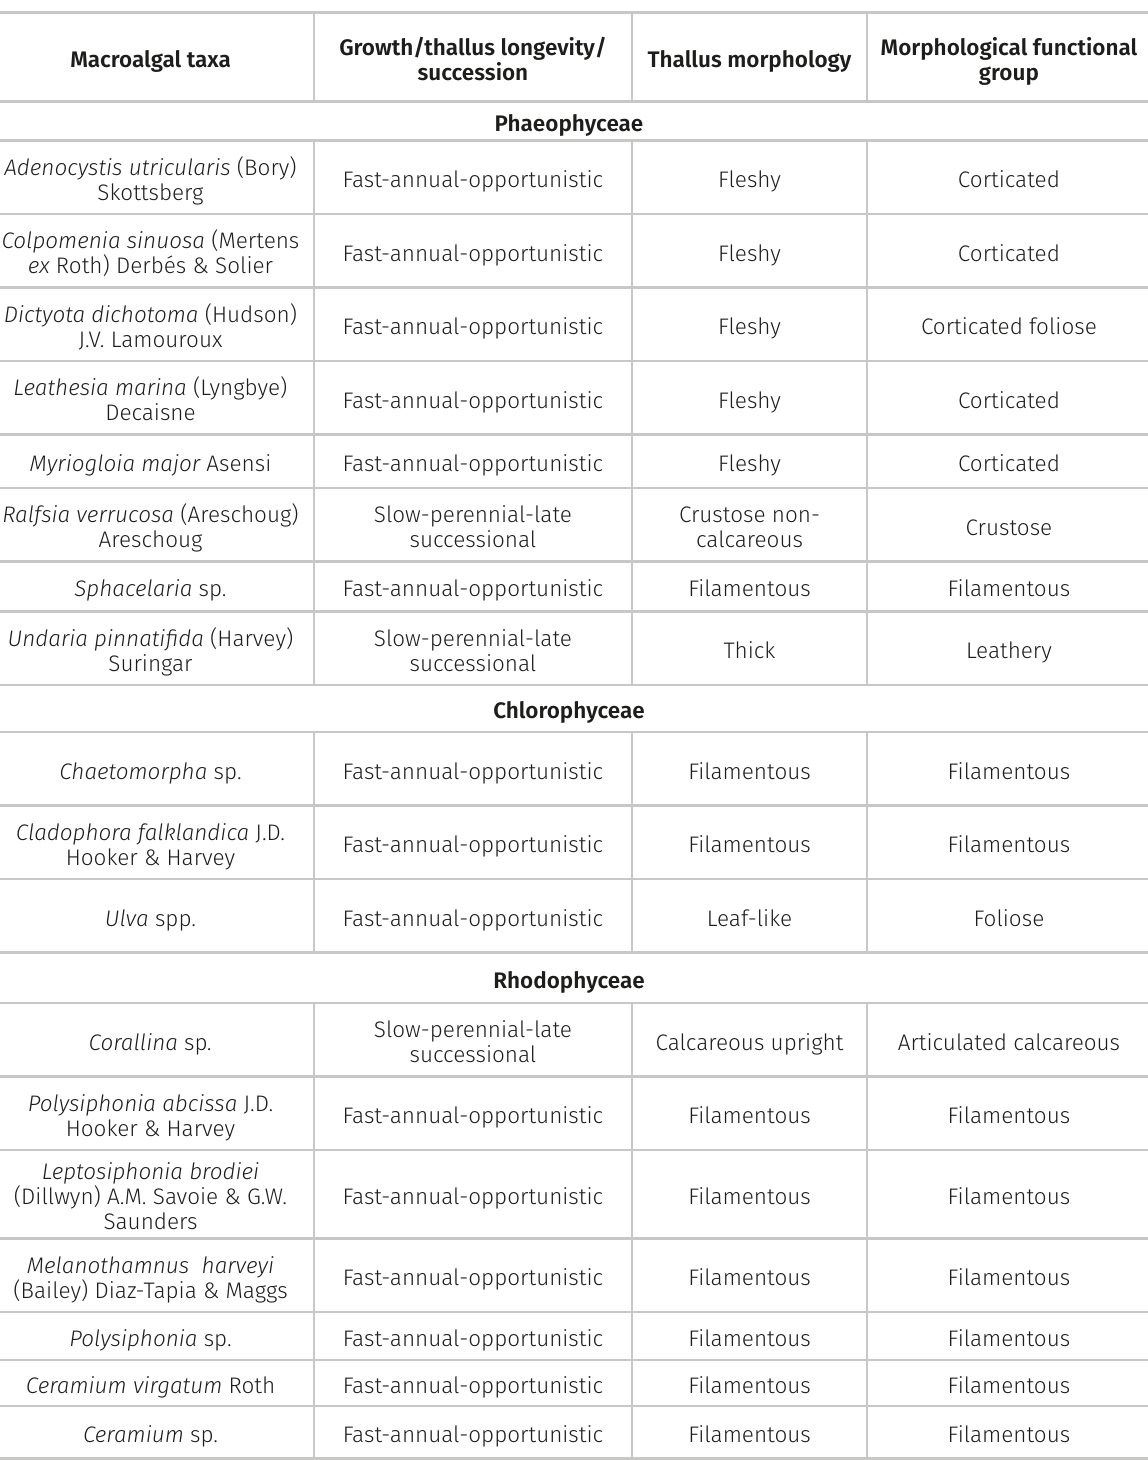
Table I. Algal taxa assignments in term of growth/thallus longevity/succession, thallus morphology and morphological functional